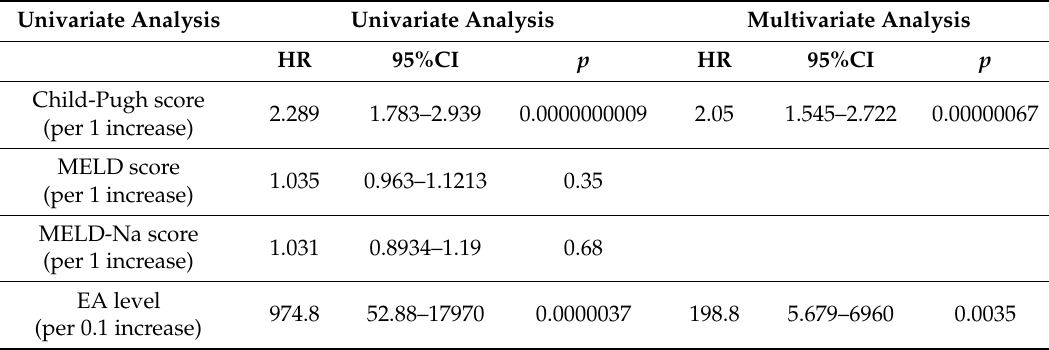
Table 3. Univariate and multivariate analysis of the association of patient characteristics and development of ACLF.